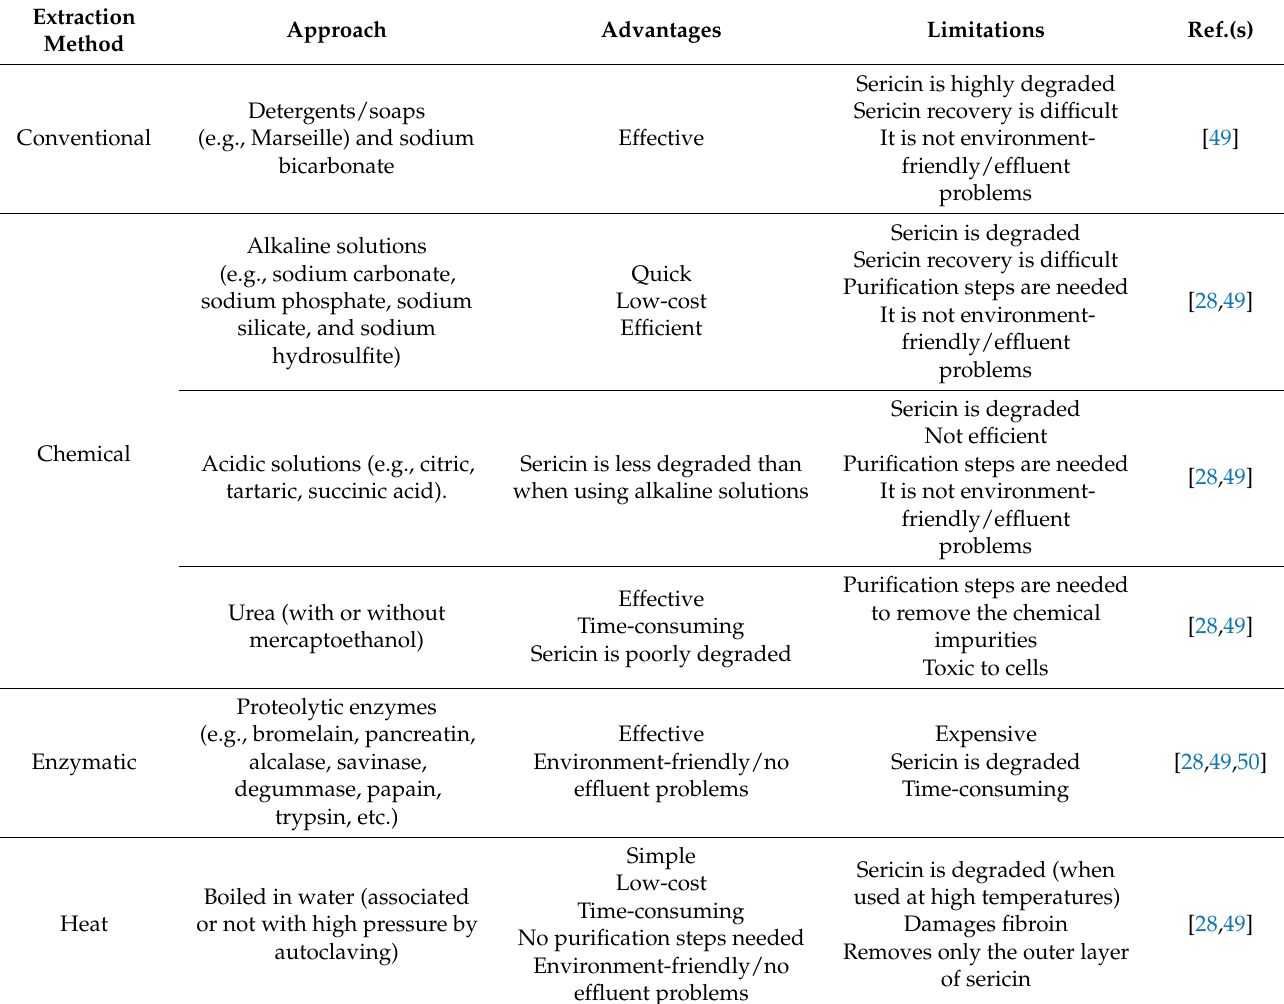
Table 1. Overview of the main methods used to extract sericin from B. mori